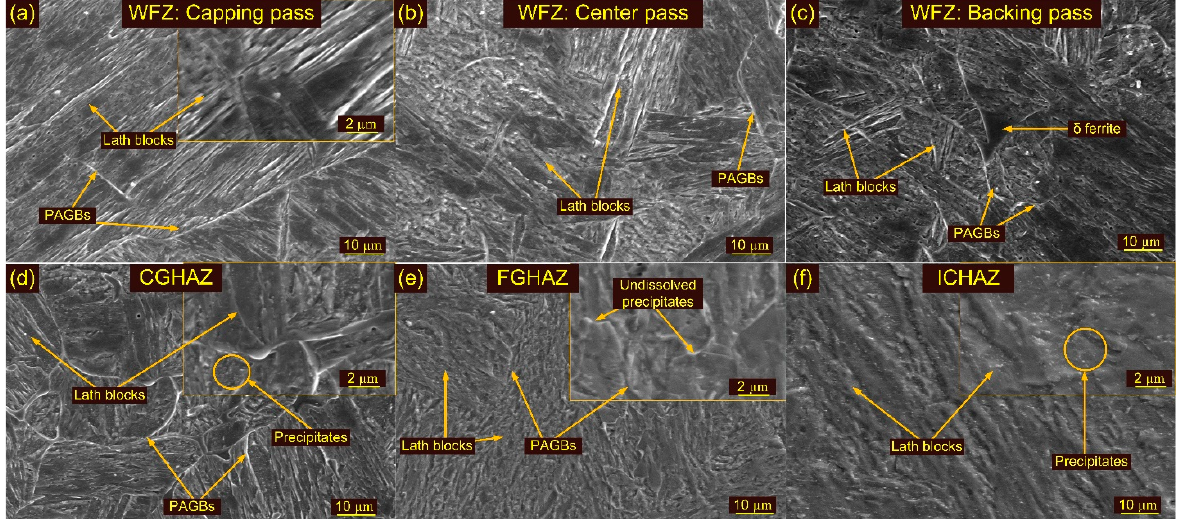
Figure 6. SEM images along weldments: WFZ corresponding to ( a ) capping pass, ( b ) center pass, ( c ) backing pass; ( d ) CGHAZ, ( e ) FGHAZ, ( f ) ICHAZ.